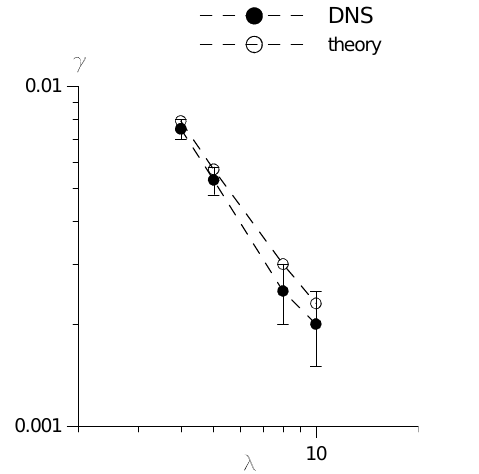
Fig. 6. Damping rate of IW γ caused by turbulence obtained from the data in Fig. 5 vs. IW wavelength λ and the analytical estimate (20).